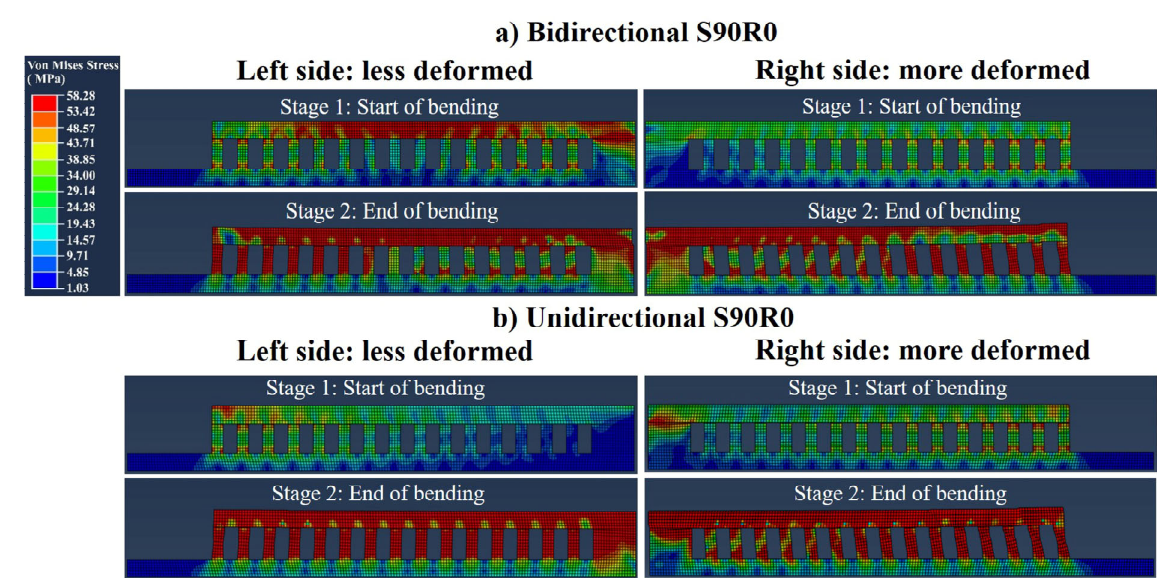
Figure 16. Stress simulated bending of the trusses for ( a ) bidirectional and ( b ) unidirectional S90R0 parts. Note that left side bent less compared to the right side of the parts.